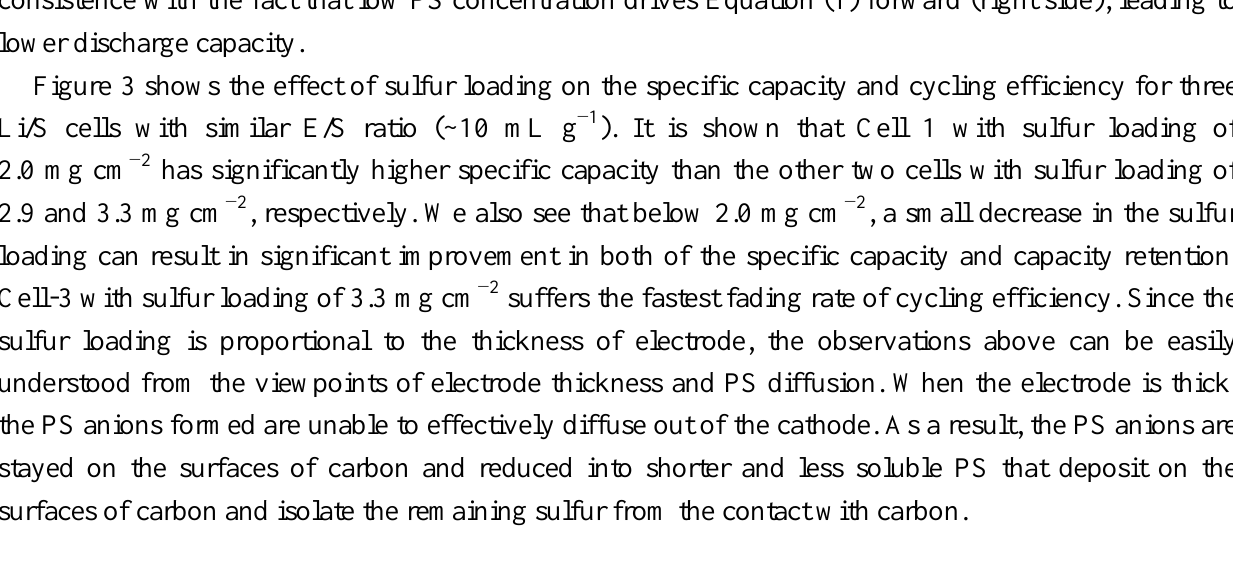
Figure 3. Effect of sulfur loading on the cycling performance of Li/S cells with an E/S ratio of ~10 mL g −1 . ( 1 ) S=2.0 mg cm −2 (○ and ●), ( 2 ) S=2.9 mg cm −2 (□ and ■), and ( 3 ) S=3.3 mg cm −2 (∆ and